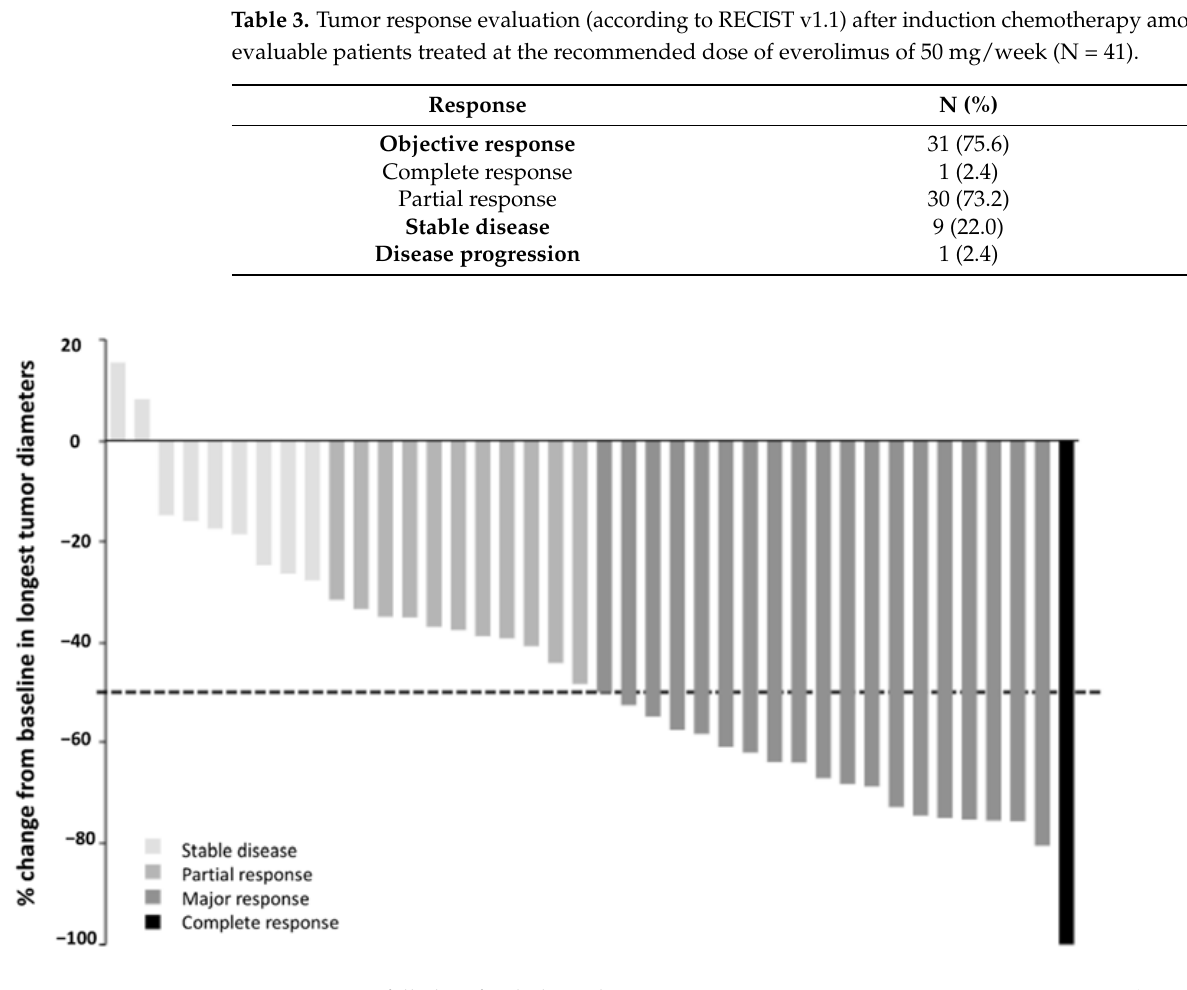
Figure 2. Waterfall plot of radiological response per RECIST v1.1 in non-progressive patients (N = 40). The dotted line depicts the 50% cut-off for major response.